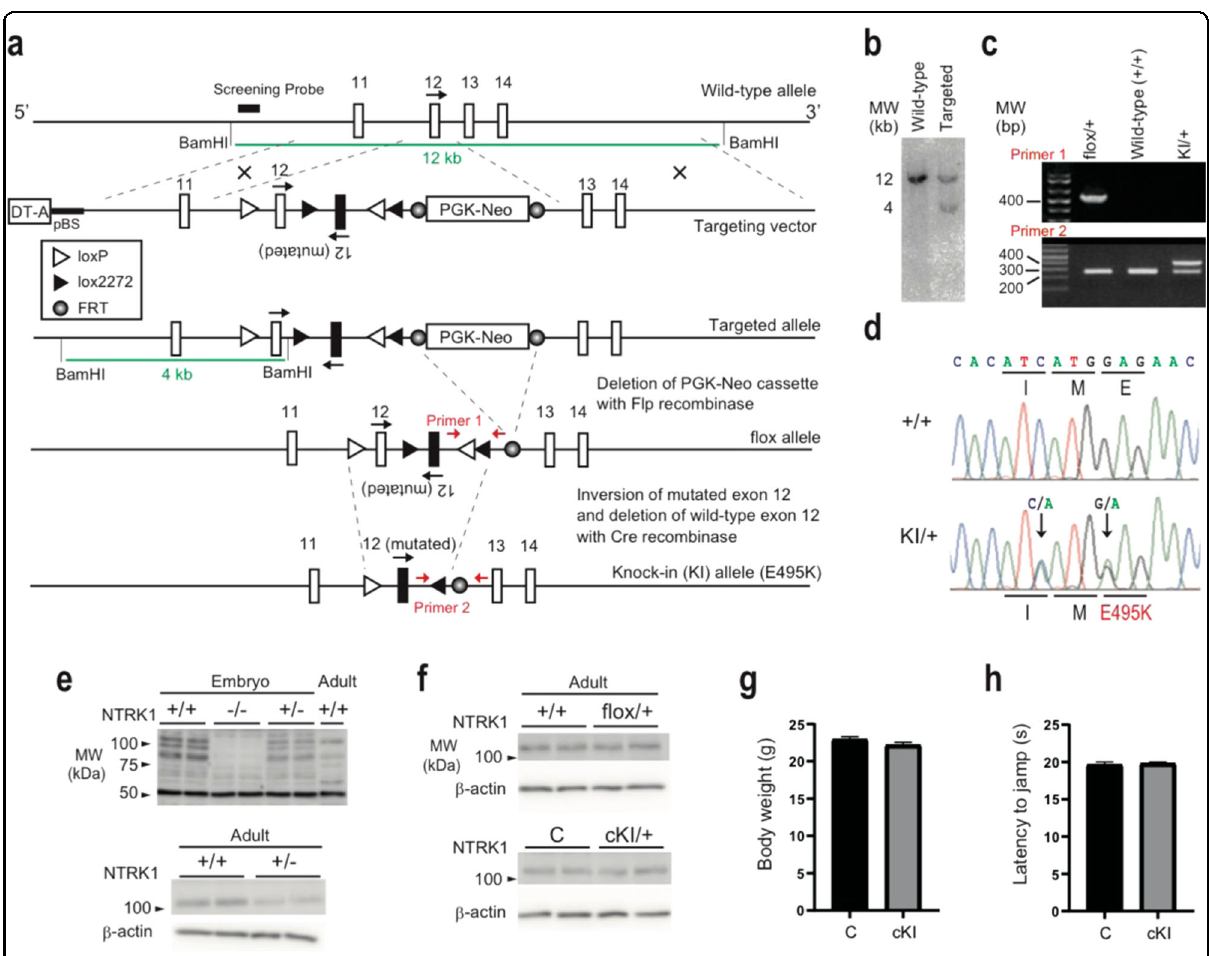
Fig. 3 Generation of the brain-speci fi c NTRK1 E495K knock-in (cKI) mice. a Gene targeting strategy. b Southern blot of the targeted ES cells. c PCR genotyping of the Ntrk1 recombined alleles. d Genomic DNA sequencing of the wild-type and KI alleles. e Validation of the anti-NTRK1 antibody speci fi city by western blots. Whole brain tissues were used for knockouts embryos (embryonic day 18). Cerebral cortices were used for the adult mouse samplesf) Expression levels of the NTRK1 protein among genotypes. C control. g Body weight. N = 13 for each genotype. h Hot plate test to assess the pain sensitivity. N = 13 for each genotype. Error bars, mean ±